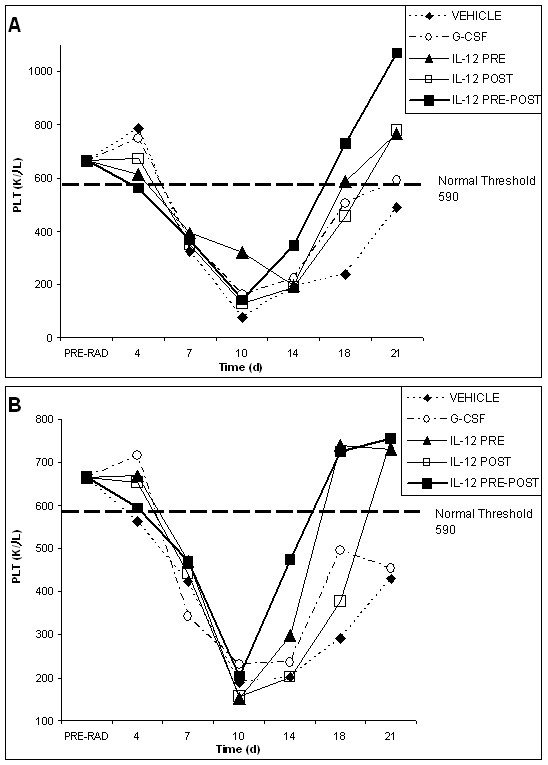
Platelet recovery profiles for vehicle, G-CSF, IL-12 pre-only, IL-12 post-only and IL-12 pre-post treatment groups following radiation (625 rad). Platelet recovery profiles are shown for the EL4 tumor model in (A) and the Lewis lung cancer model in (B). Pre-radiation blood values reflect an average of all animals in both groups (70 mice) before radiation and tumor inoculation. The normal threshold value for murine platelet counts is indicated. Following the initial dose of vehicle or cytokine, 4 subsequent doses were given every 3–4 days following radiation. IL-12 treated mice received a total dose (5 single doses) of 220 ng, whereas G-CSF treated mice received a total dose (5 single doses) of 5 μg.